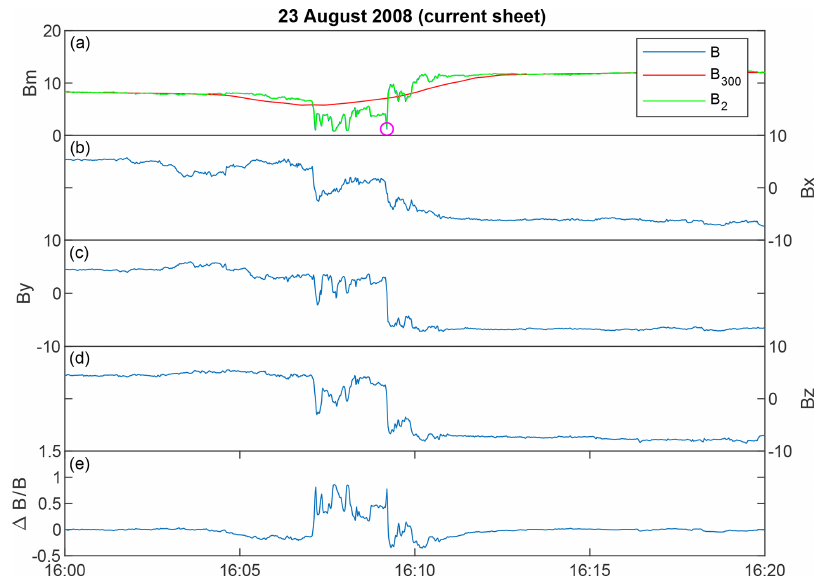
Figure 4. A current sheet event on 23 August 2008 at 16:07UT with rotation over the structure (cid:50) > 170 ◦ and depth (cid:49)B/B 300 > 0 . 8. The format of the figure is the same as in Fig. 3. The magenta circle in panel (a) was identified as a MH candidate by the search program.